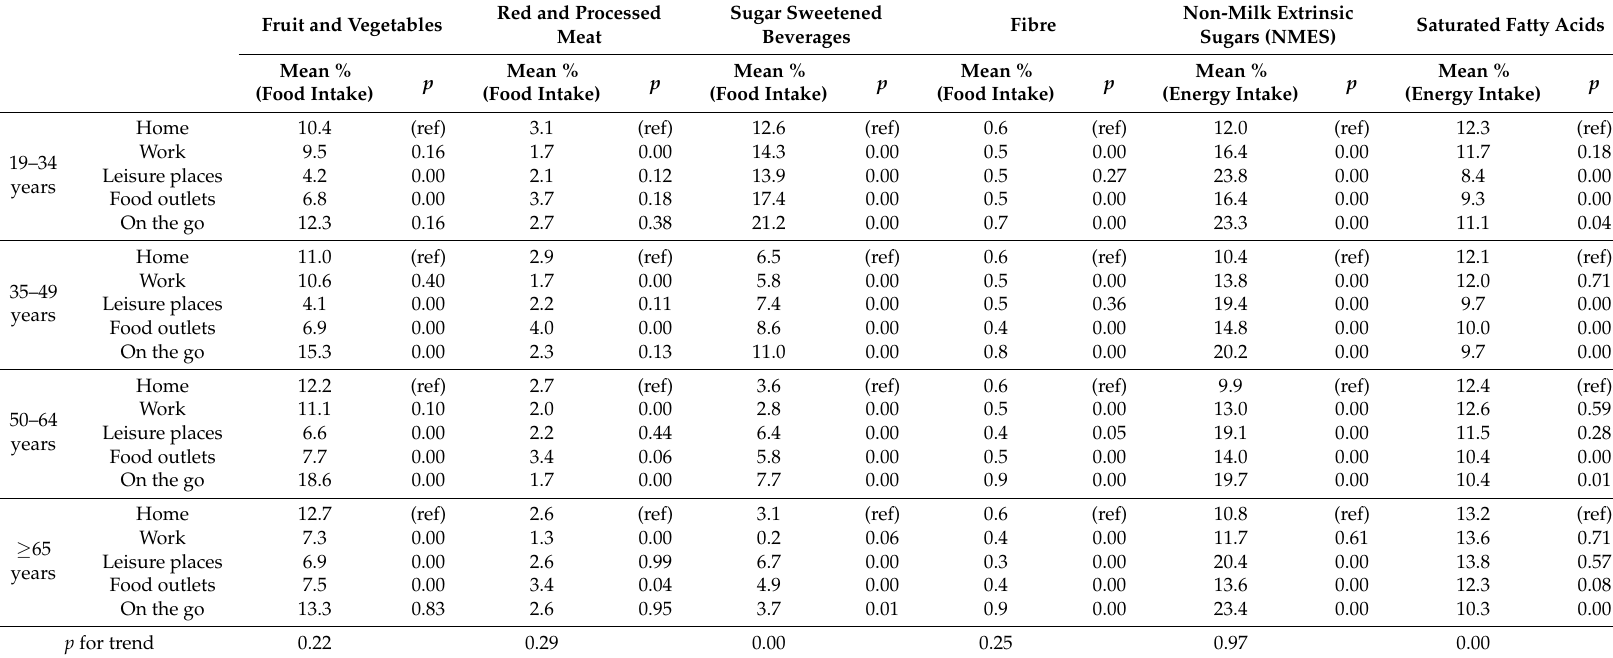
Table 2. Consumption of selected foods and nutrients by reported eating location from the NDNS RP Years 1–4 (2008–2012), as a percentage of overall consumption per location and age group. Results of logistic regression are indicated under the respective p columns using Home as the reference category indicated as “(ref)”. The interaction between age group and selected foods and nutrients was tested using the same models and is shown at the bottom of the